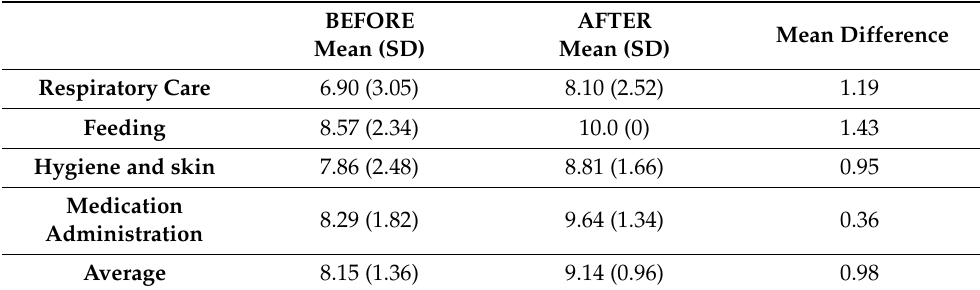
Table 5. Mean score in the theoretical knowledge test before and after the training program, and the mean differences.